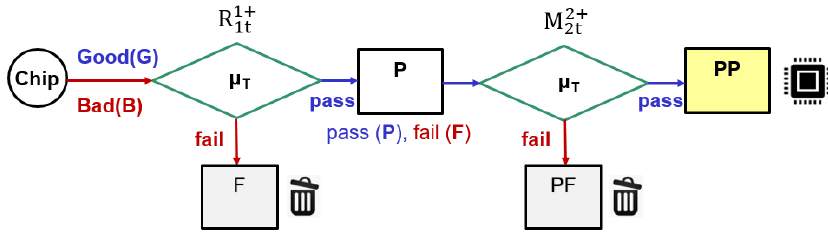
Figure 8. Multiplex testing decision diagram ( M (cid:2870)(cid:2930)(cid:2870)(cid:2878) ).